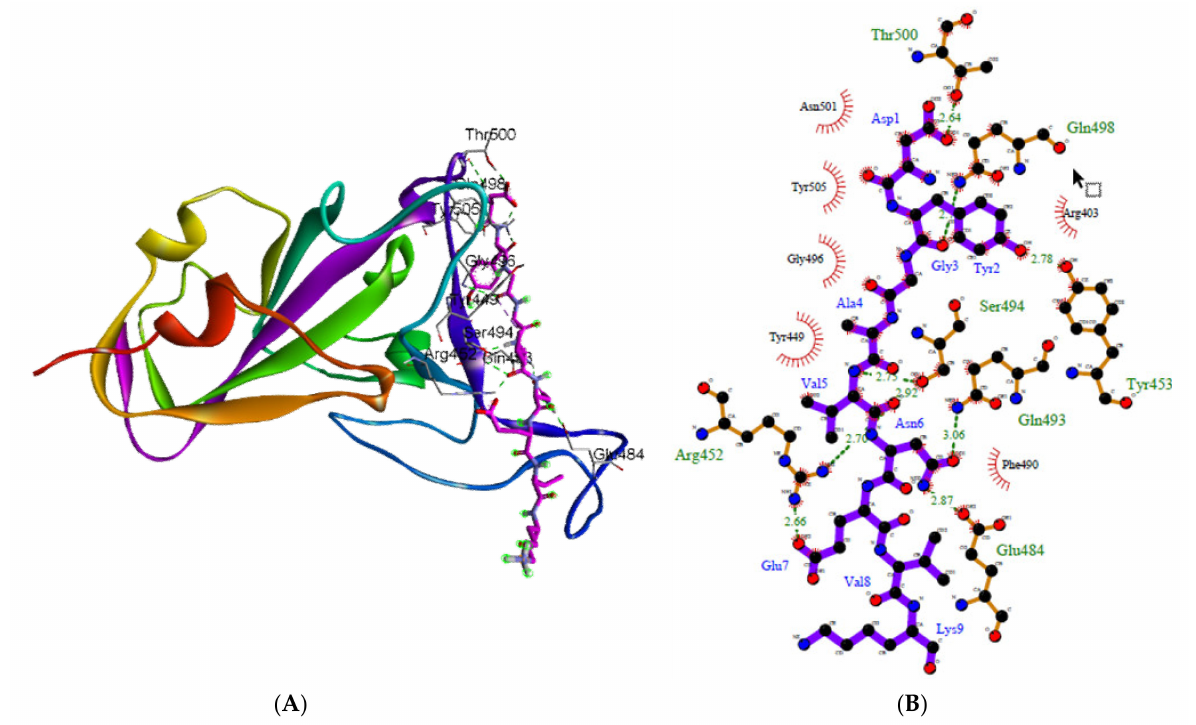
Figure 3. Sketch diagram depicting the 3D ( A ) and 2D ( B ) interactions between bromelain-derived peptide and RBD WT from